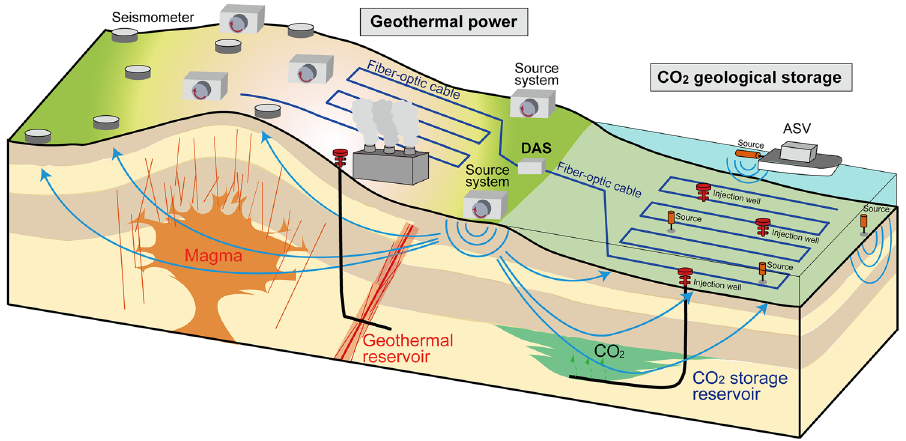
Figure 10. Schematic image of continuous monitoring systems and seismometer networks, including a DAS array. We manage the multi-reservoir using our continuous monitoring